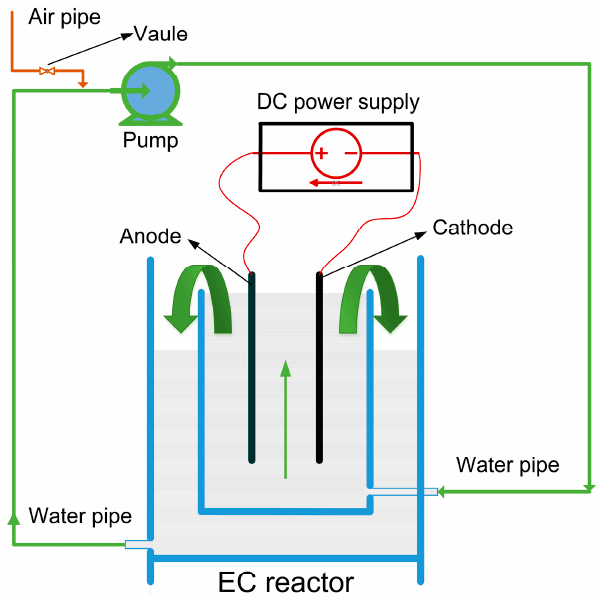
Figure 1. Schematic diagram of the electrocoagulation (EC) setup.